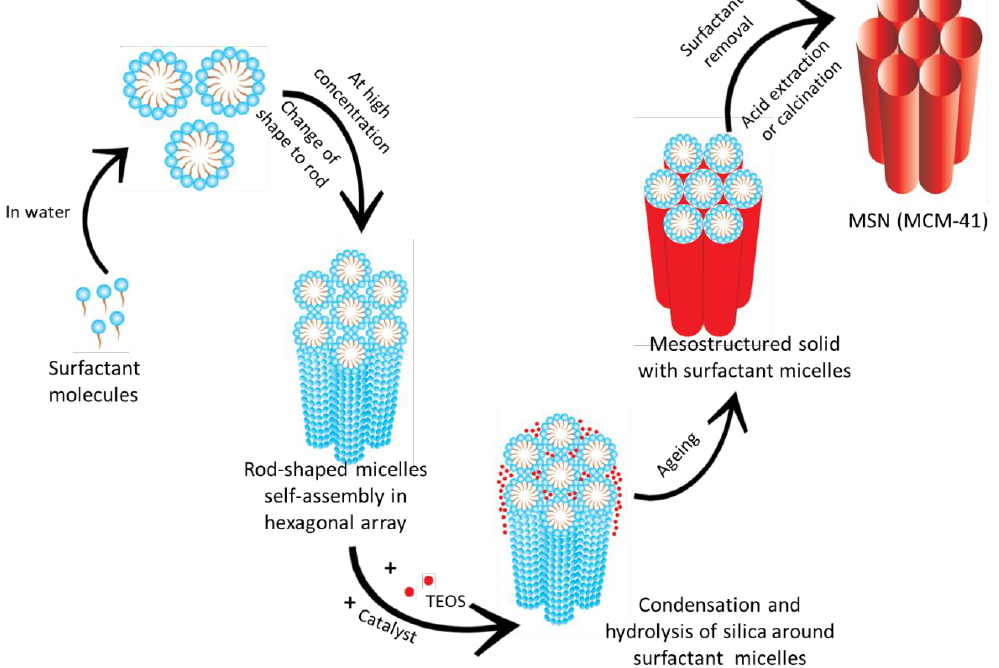
Figure 2. Mechanism of formation of Mobil Crystalline Materials No.41( MCM-41).